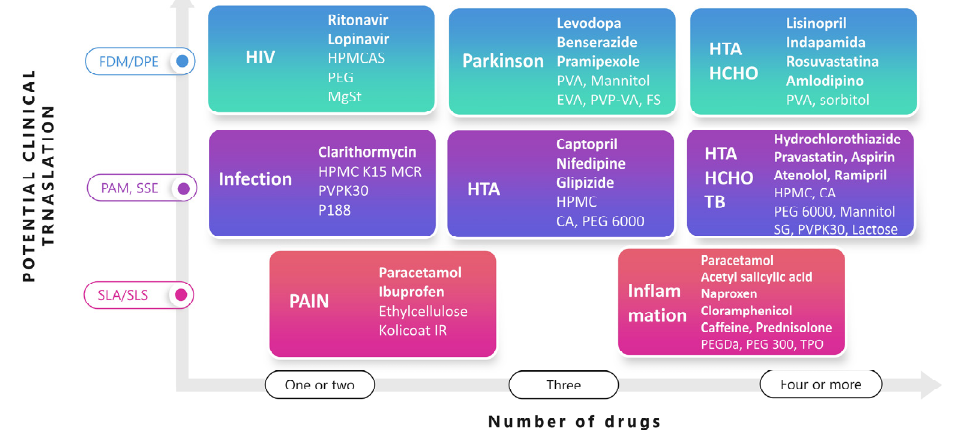
Figure 6. 3D printing of mono- and polypills. Key: SSE, semisolid extrusion also known as PAM; FDM, fuse deposition modelling; DPE, direct powder extrusion; SLA, stereolithography; SLS, selec- tive laser sintering; HTA, hypertension; HCHO, hypercholesterolemia; TB, thrombosis; HPMCAS, hydroxypropyl methylcellulose acetate succinate; MgSt, magnesium stearate; PEG, polyethylene glycol; HPMC, hydroxypropyl methylcellulose; CA, acetate cellulose; PVA, polyvinyl alcohol; PEGDA, polyethylene glycol diacrylate; PVPK30, polyvinylpyrrolidone K30; SG, sodium starch glycolate; TPO, thermoplastic polyolefin used as photoinitiator; EVA, ethylene-vinyl acetate copolymer (82:18, w : w ); PVP-VA, vinylpyrrolidone-vinyl acetate copolymer 60:40; FS, fumed silica; P188, poloxamer 188.